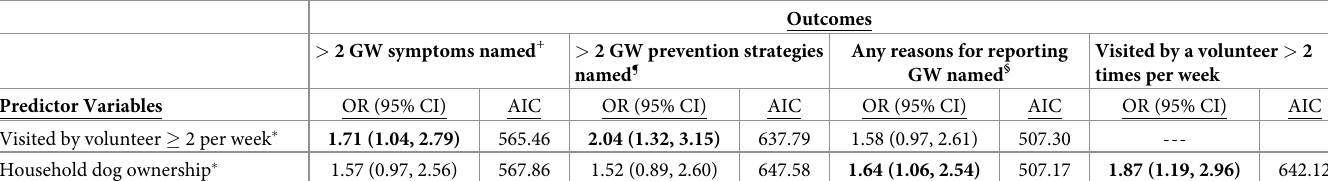
(Table 2). The outcome variables (Guinea worm symptoms, prevention strategies, and motivation to report) were classified into binary variables based on naming a specified number of items (threshold). The thresholds for each outcome were defined as two correctly identified symptoms, two correctly identified prevention strategies, and any reasons for reporting (i.e., motivation to report). Thresholds were determined by calculating the mean number of correct responses for each outcome variable. (Response options were chosen to reflect the key messages that are pro- moted by CGWEP, such as identifying blisters as a symptom, tethering infected dogs and cats to prevent them from entering water sources, and reporting cases to stop transmission.) Visit fre- quency (both an outcome and predictor) was measured for volunteers based on villager reports, and possible responses were dichotomized at two days per week so that about half of the observa- tions fell into each category. The predictor variable, dog ownership, was measured based on whether the household owned a dog, as reported by the survey respondent. A repeated measures term (fixed effect) was included to account for clustering by village. We also adjusted for the number of confirmed canine Guinea worm cases at the village-level between 2018 and June 2019 because we hypothesized that infection levels were a common cause of the predictors and the outcomes [24]. As a secondary analysis, we explored the number of years a village was under active surveil- lance as a predictor of the outcome variables listed above (ability to name Guinea worm symp- toms and prevention strategies, motivation to report, and volunteer visit frequency). Active surveillance start year, from CGWEP data, was used to calculate the number of years of active surveillance per village, up to and including the year 2019. Years of active surveillance were dichotomized at the mean (five years) (S3 Table). Table 2. Villager-Level Models: The impact of volunteer visits and dog ownership on Guinea worm knowledge (n = 468 villagers) in the survey to evaluate the Chad Guinea Worm Eradication Program active surveillance system: September 2019. Guinea worm knowledge was assessed by symptoms named, strategies named, and reasons for reporting Guinea